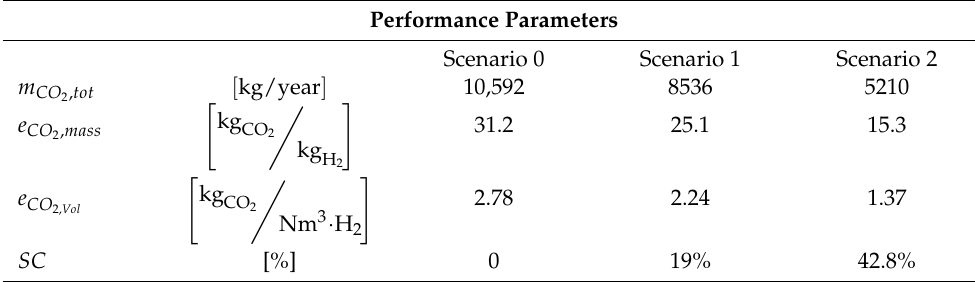
Table 5. KPIs of the plant-dependent from the scenarios